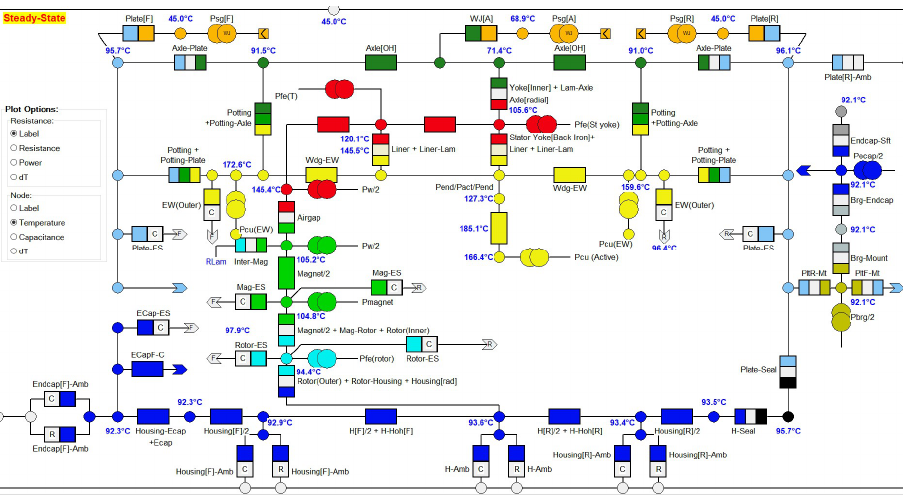
Figure 6. Simplified equivalent thermal diagram of the motor in the ANSYS Motor-CAD program .